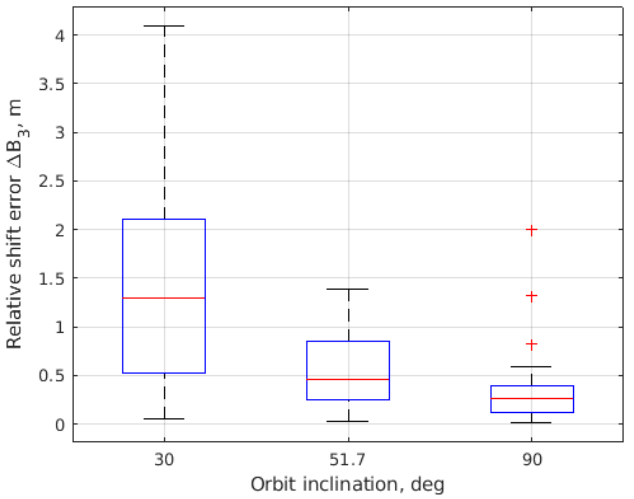
Figure 20. Mean error in